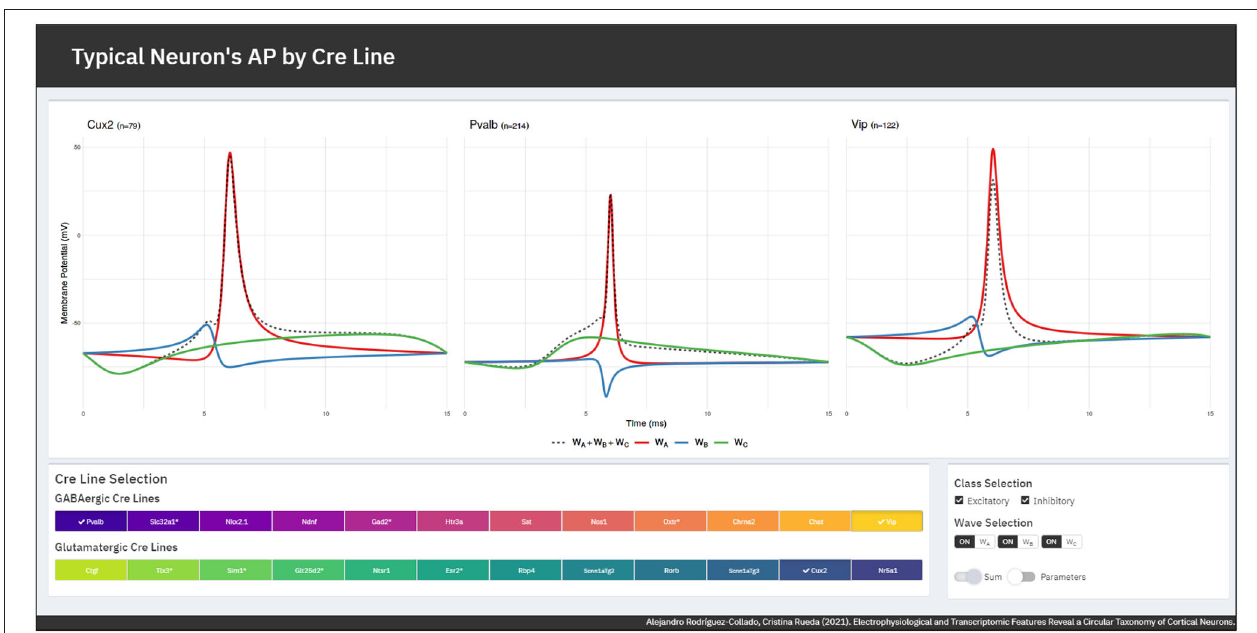
FIGURE 3 | App interface. (Top) Cre lines’ median APs (dashed lines) along with the wave decomposition (solid lines). (Bottom) Interface controls for the selection of the Cre lines and the displayed